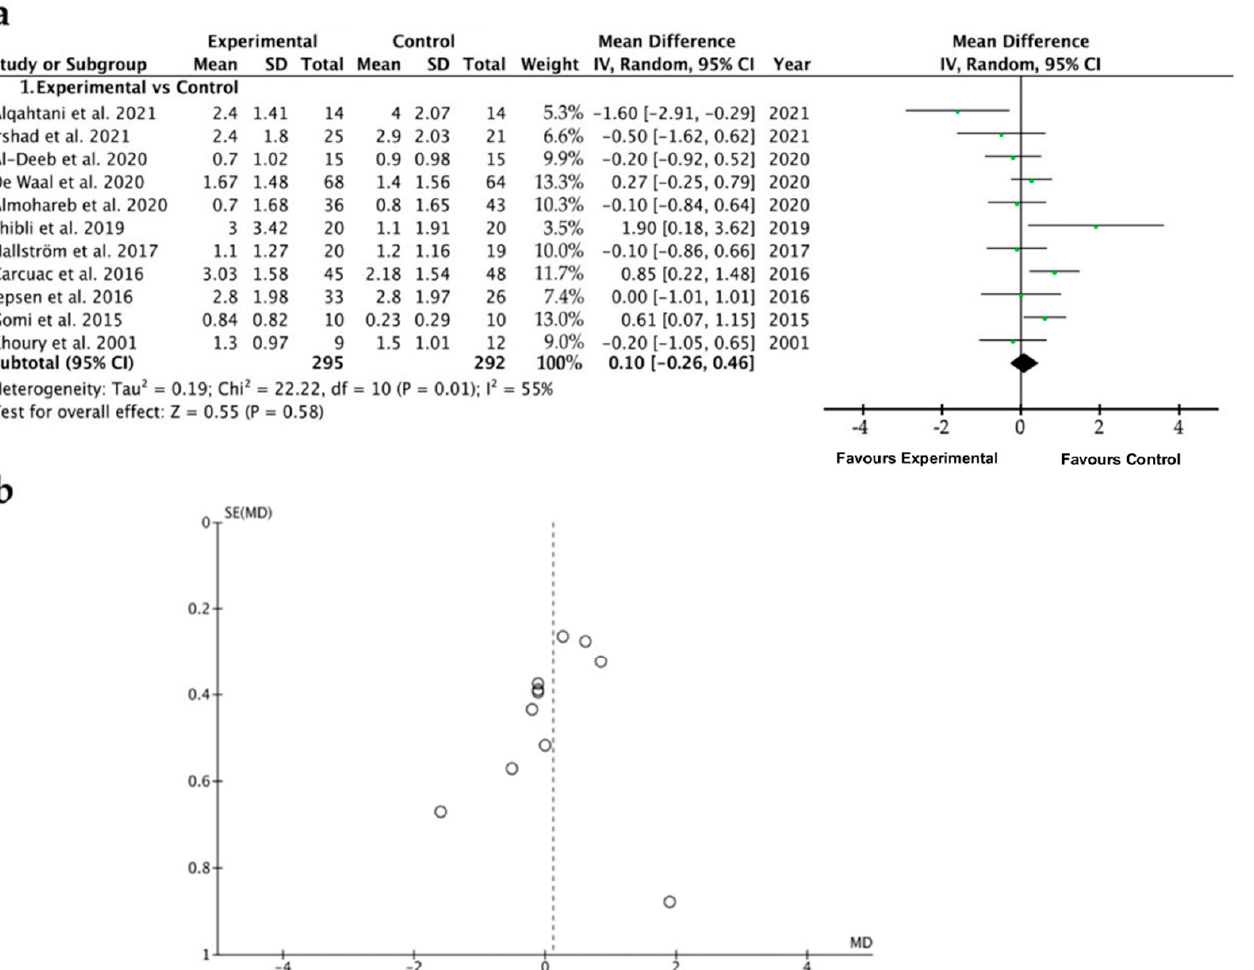
Figure 6. ( a ) Forest plot for no systemic antibiotic (control group) versus adjunct systemic antibiotic (test group) when comparing peri-implant probing pocket depth (PPD). ( b ) Funnel plot graph illustrating the publication bias and the systematic heterogeneity of the included studies. The